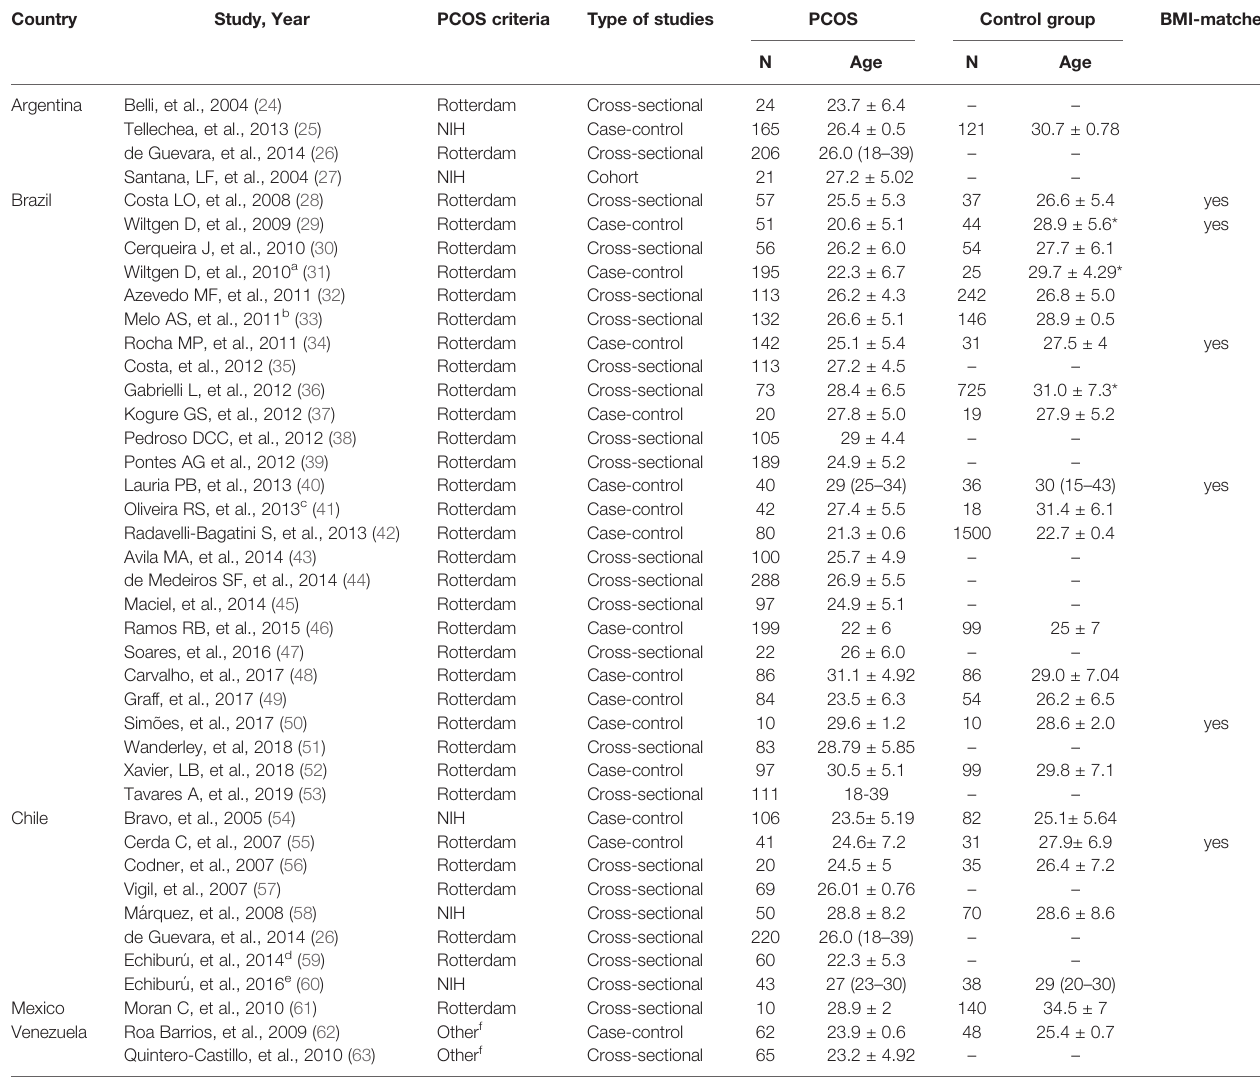
a dataarefromAplusBPCOSphenotypesvscontrols; b dataarefromAPCOSphenotypevscontrols; c womenincludedinthecontrolgrouphadsimilarcomplaintsastheonesfromthe PCOS group, but did not meet the diagnostic criteria; d data are from baseline and regarding the phenotype A only; e data shown from the early reproductive age group (18 – 34 years); f PCOS diagnosis de fi ned by the authors; * p < 0.05 between the